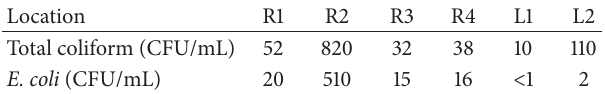
Table 2: Bacterial water quality in Yangon.